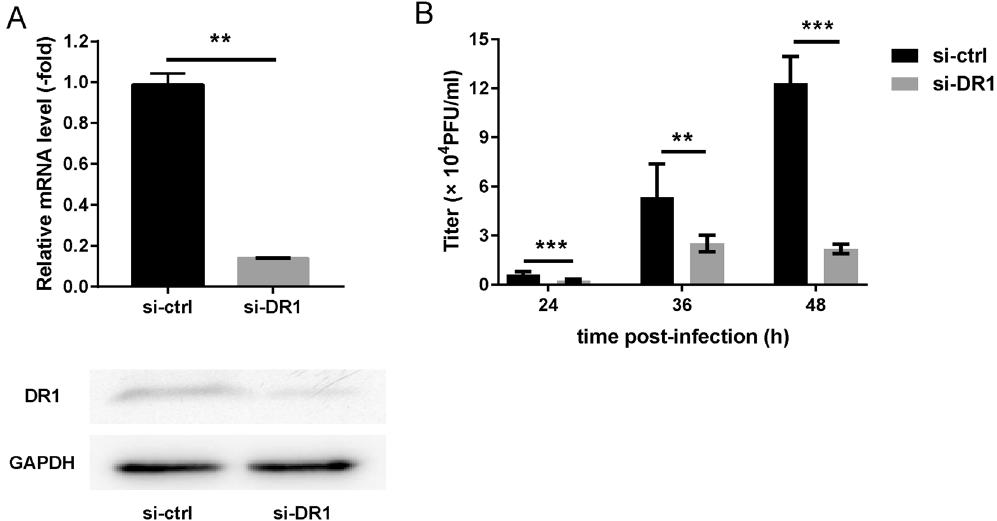
Figure 7. Silencing down-regulator of transcription 1 (DR1) inhibits influenza A virus (IAV) replication. ( A ) A549 cells were transfected with DR1-specific siRNA (si-DR1) for 48 h, and abundance of DR1 was measured by quantitative real-time PCR (qPCR) and western blotting. Full-length blots are presented in Supplementary Figure S9. Data are expressed as the mean + SD of three independent experiments. * p < 0.05; ** p < 0.01; *** p < 0.001 (Student’s t test). ( B ) miR-203 knockout cells were transfected with si-DR1 or si-control for 48